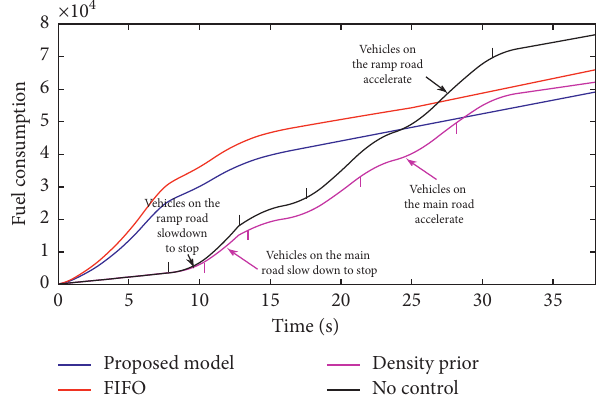
Figure 13: Comparison of fuel consumption for different models in Case Study 2.